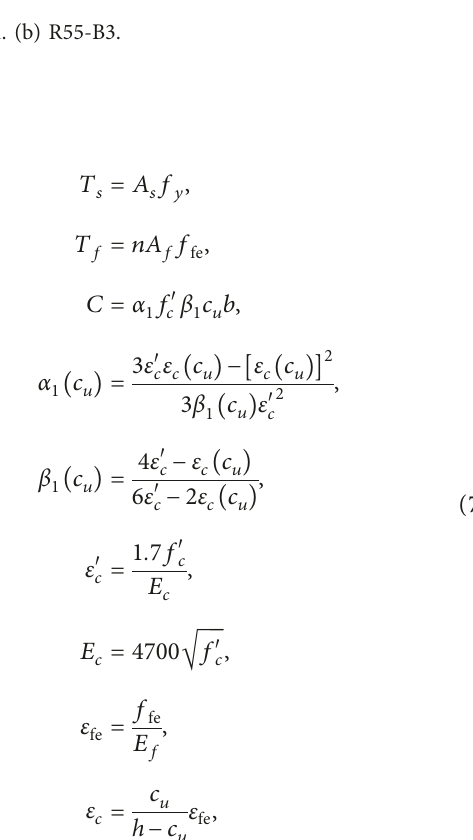
Figure 7: Load-strain relation. (a) R55-B1. (b)